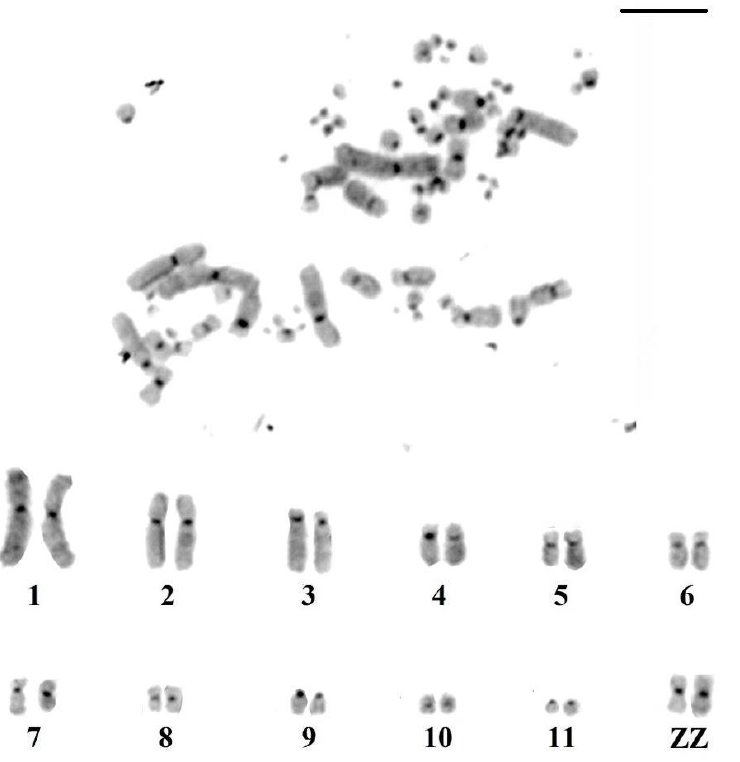
Figure 2. Distribution of constitutive heterochromatin in the karyotype of M. americana (bar = 10µm).